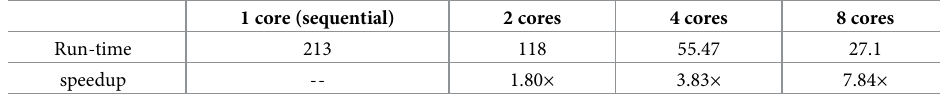
Table 1. The running time in seconds required to extract 961 features from one